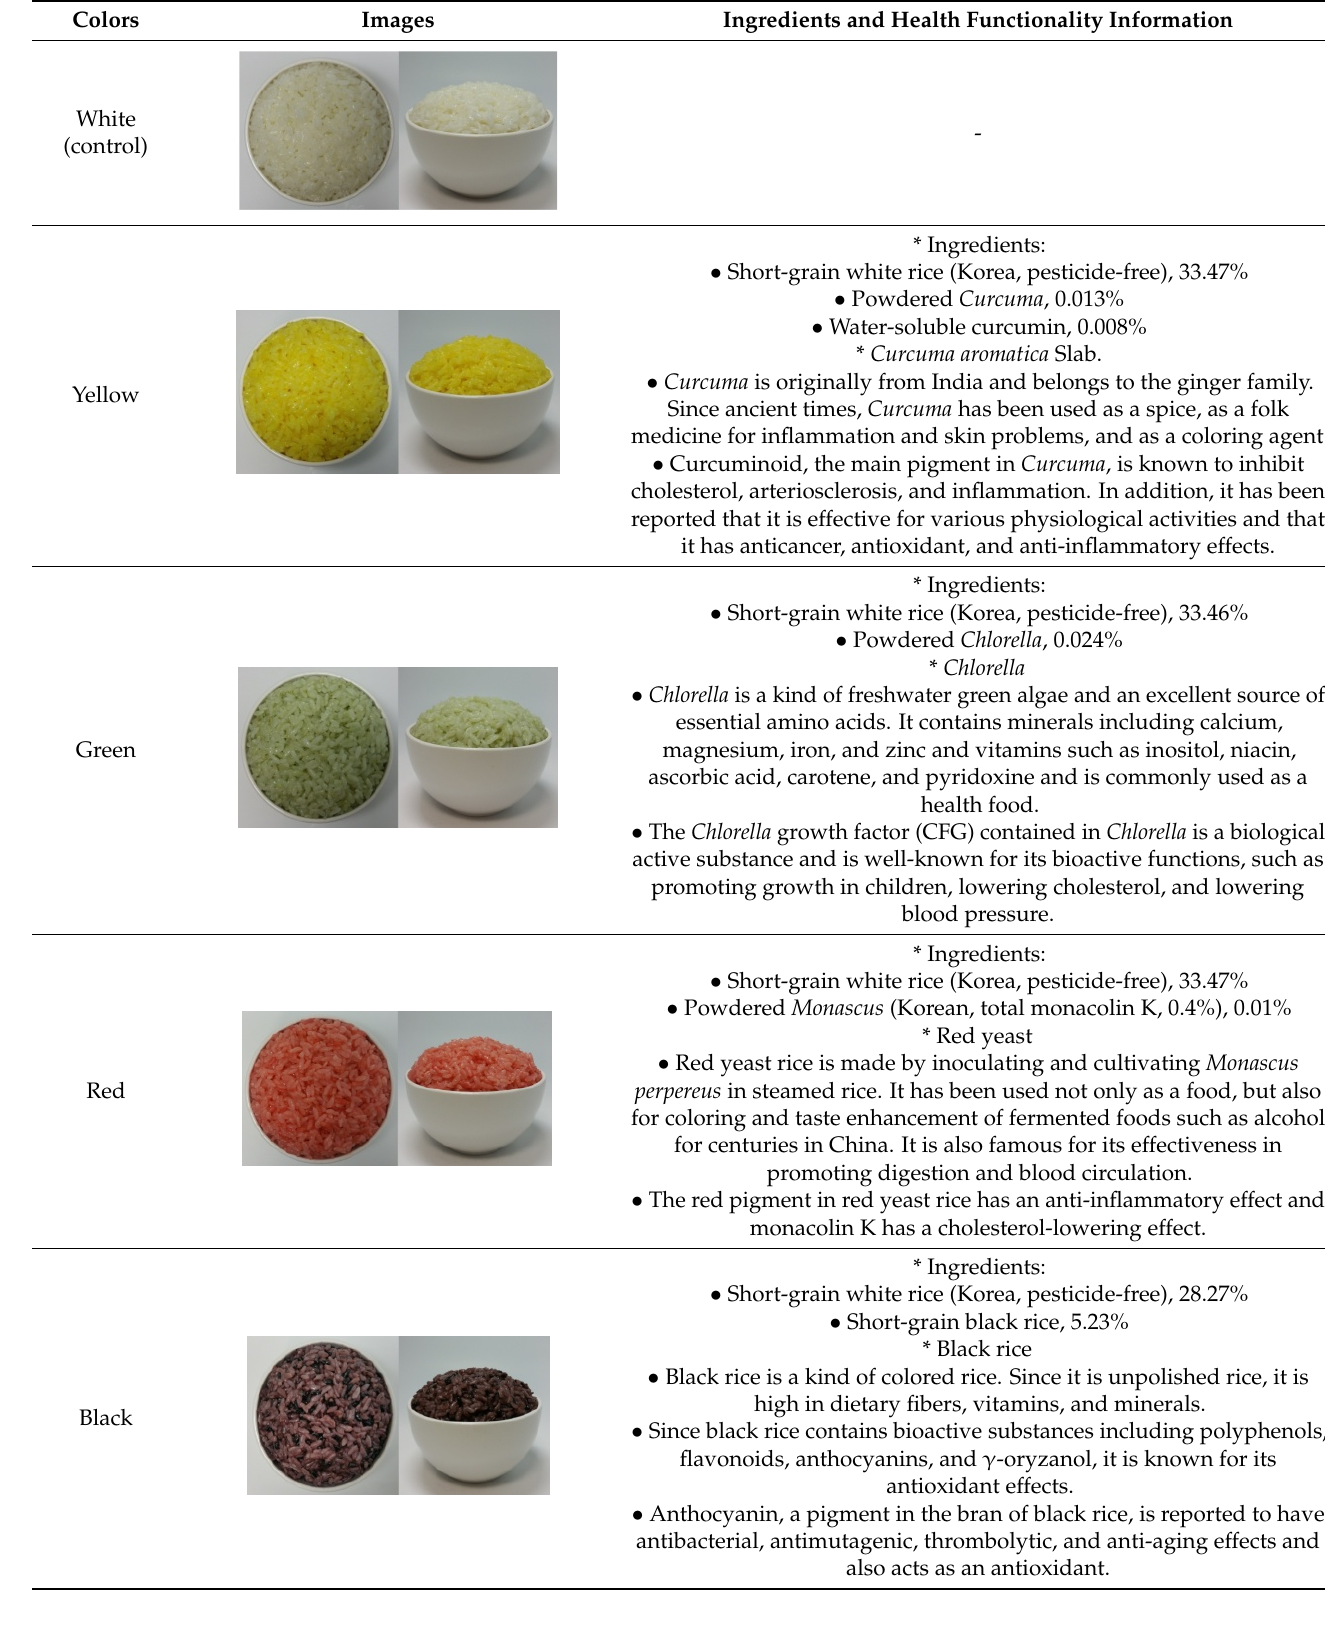
Table 1. Images and ingredients and health functionality information of the stimuli.